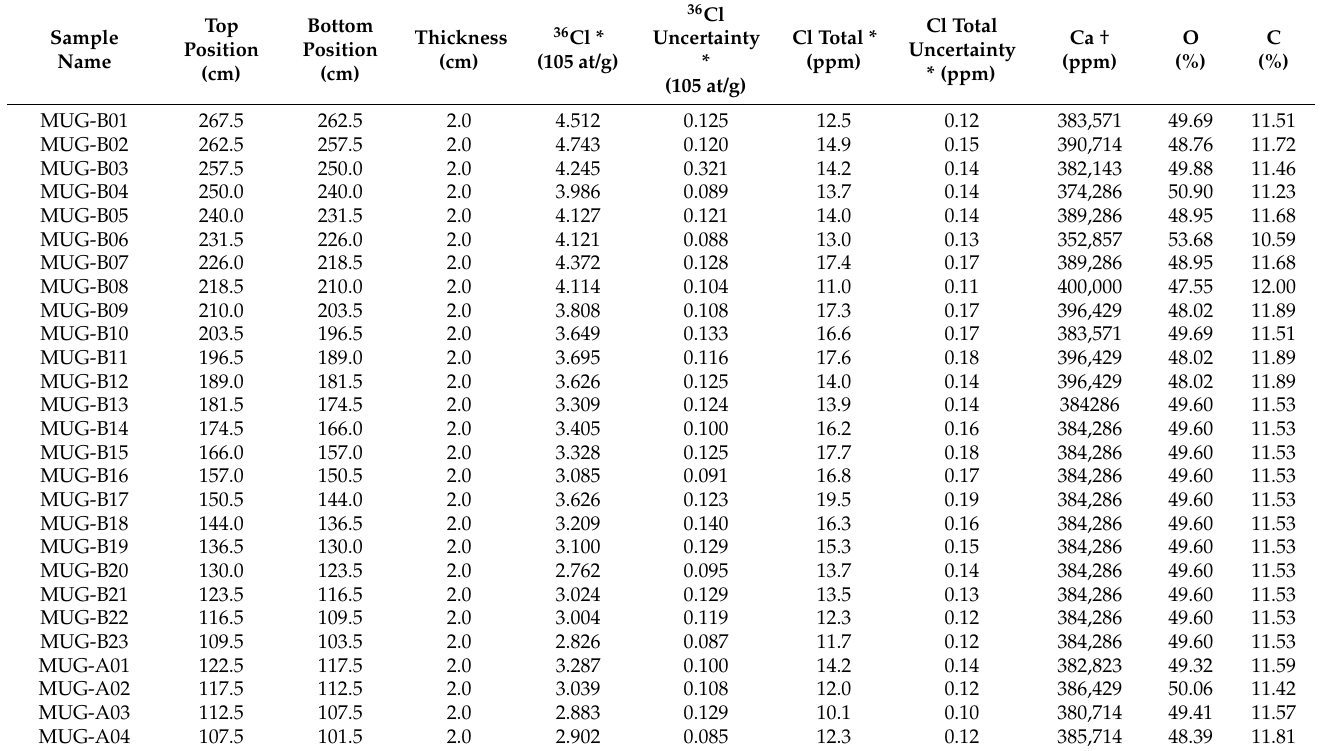
Table 3. Cosmogenic nuclide data of the Mugırtepe scarp